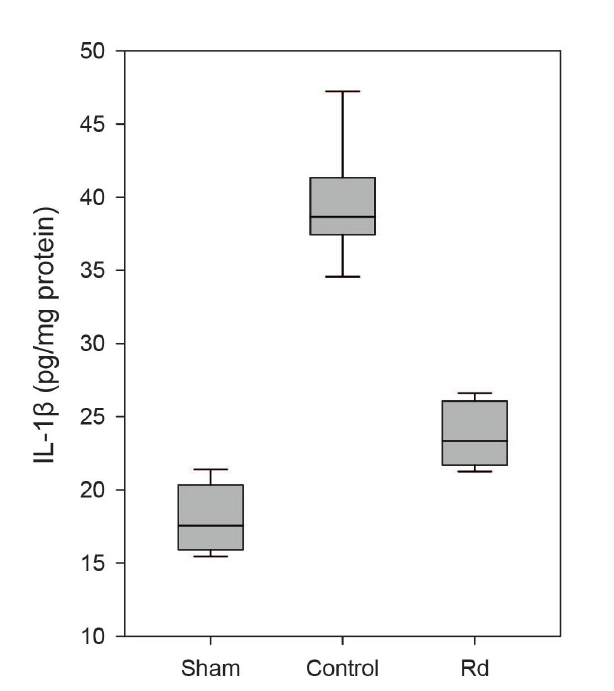
Fig. 4D - Boxplot of the levels of interleukin-1 beta (IL-1β) in each group. Significantly lower levels of IL-1β were observed in the Rd group compared to those in the control group (P<0.001). Conversely, significantly higher levels of IL-1β were observed in the Rd group compared to those in the sham group